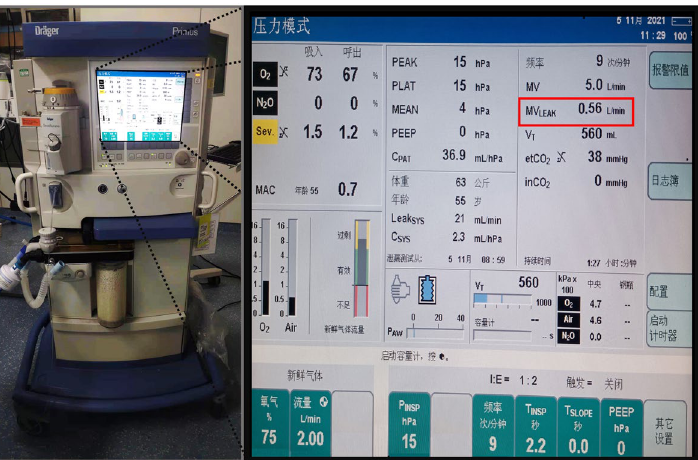
Figure 10. The air leakage during LMA ventilation is detected by the Primus anaesthesia machine. (The red box shows the leakage